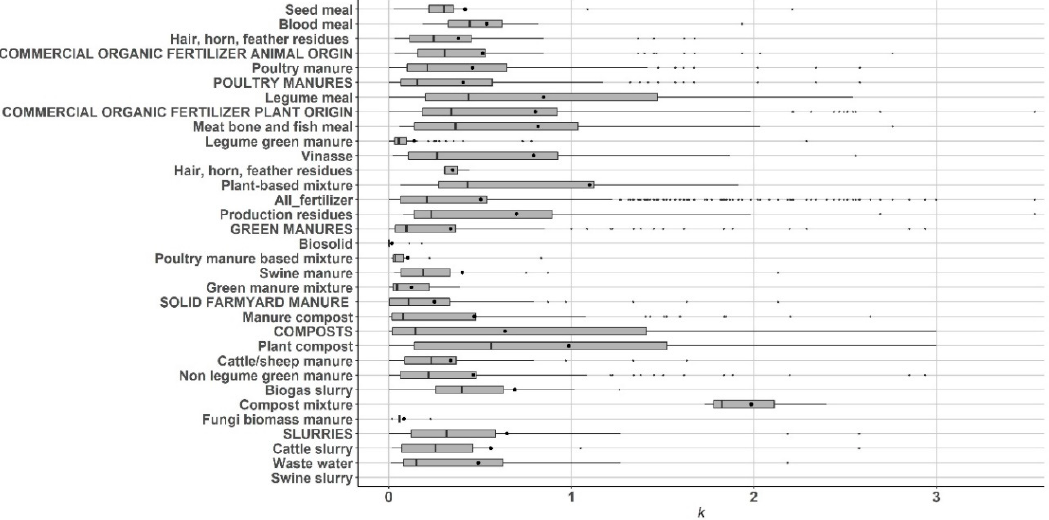
Figure 5. Boxplot of the mineralization rate constant k [°Cd] − 1 of the fertilizer main groups (capital letters) and subgroups. The circles are the means and the stripes are the medians of the observations.